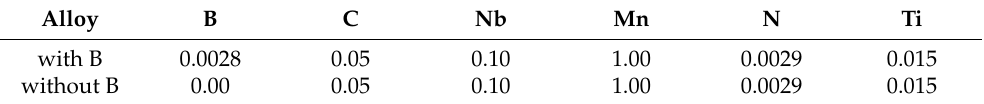
Table 1. Chemical composition (in wt.%) of the two ingots used for the experimental investigation. Alloy B C Nb Mn N Ti with B 0.0028 0.05 0.10 1.00 0.0029 0.015 without B 0.00 0.05 0.10 1.00 0.0029